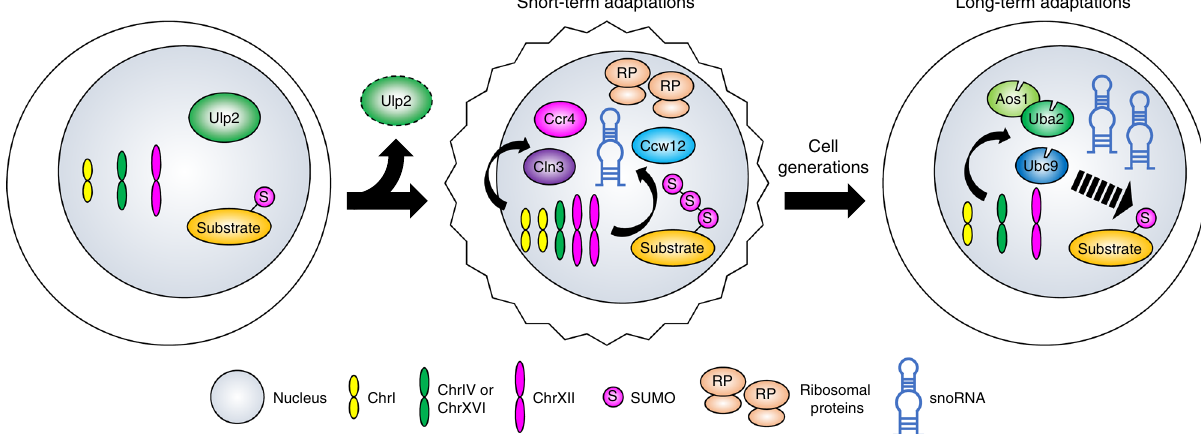
Fig. 7 Short-term and long-term adaptive mechanisms caused by loss of Ulp2. Proposed model showing that yeast have short-term and long-term adaptive mechanisms that allow survival of a dysregulated SUMO system caused by loss of Ulp2. Loss of Ulp2 leads to accumulation of polySUMO-conjugated substrates, enhanced expression of genes encoding ribosomal proteins and reduced cell fi tness (irregular cell outline). Duplication of ChrI and ChrXII provides a transient adaptive solution to amplify three protein-coding genes, CCR4 , CLN3 , and CCW12 , and several snoRNA genes, SNR61 , SNR55 , and SNR57 . Following evolution over many cell generations, disomies of both ChrI and XII are eliminated, concomitant with mutations in UBC9 , UBA2 , or AOS1 . These SUMO-ligating enzyme mutations reduce SUMO conjugation and suppress the growth defects of ulp2 Δ cells. Upregulation of numerous snoRNA genes appears to promote ribosome biogenesis, which is normally tightly regulated by the SUMO